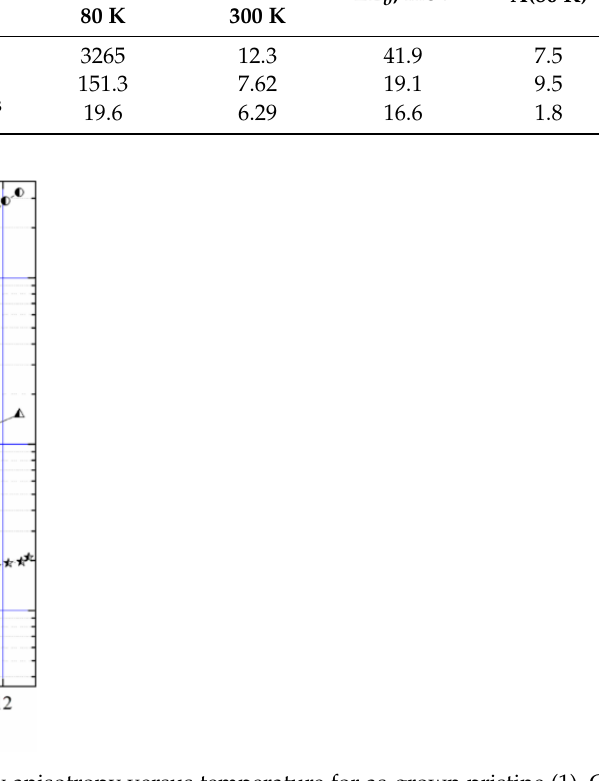
Figure 8. The electrical conductivity anisotropy versus temperature for as-grown pristine (1), Co- intercalated (2) and Co-doped (3) crystals of n -type InSe.